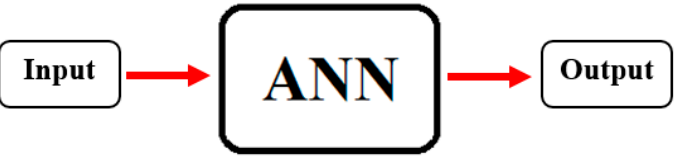
Figure 8. Deployment stage flow chart.